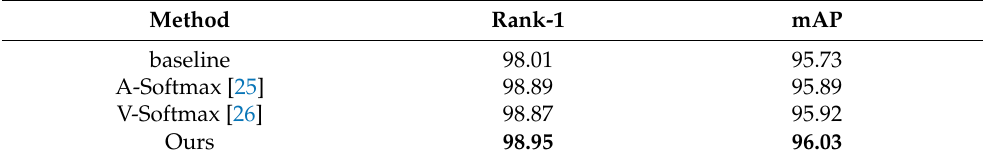
Table 6. Comparison experiments on